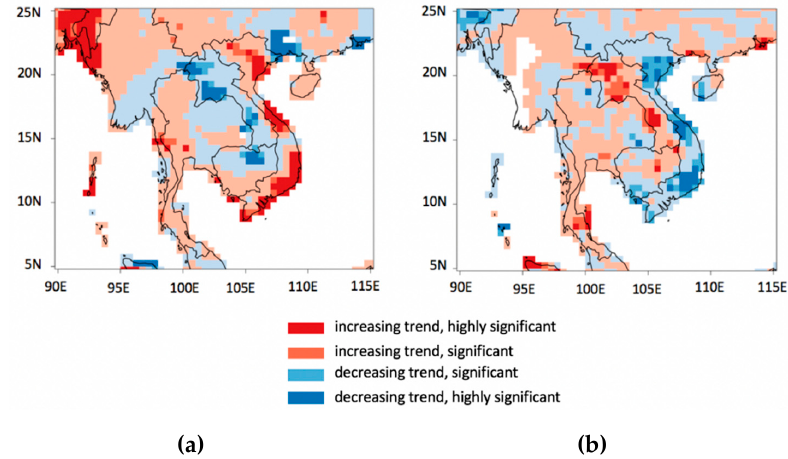
Figure 2. Trends in ( a ) spring precipitation and ( b ) extreme drought in the Indochina Peninsula. The modified Mann–Kendall (M–K) test was applied; statistically significant changes are highlighted in red (increasing trend) and blue (decreasing trend) for 90% (significant) and 95% (highly significant) confidence intervals.